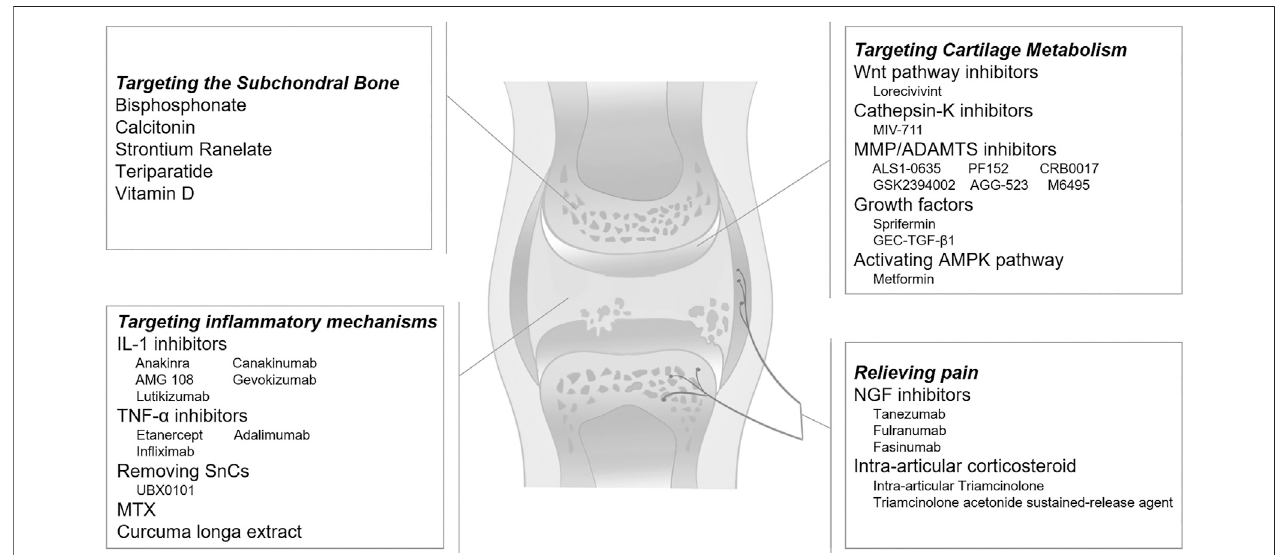
FIGURE 1 | Potential pharmacological therapies for